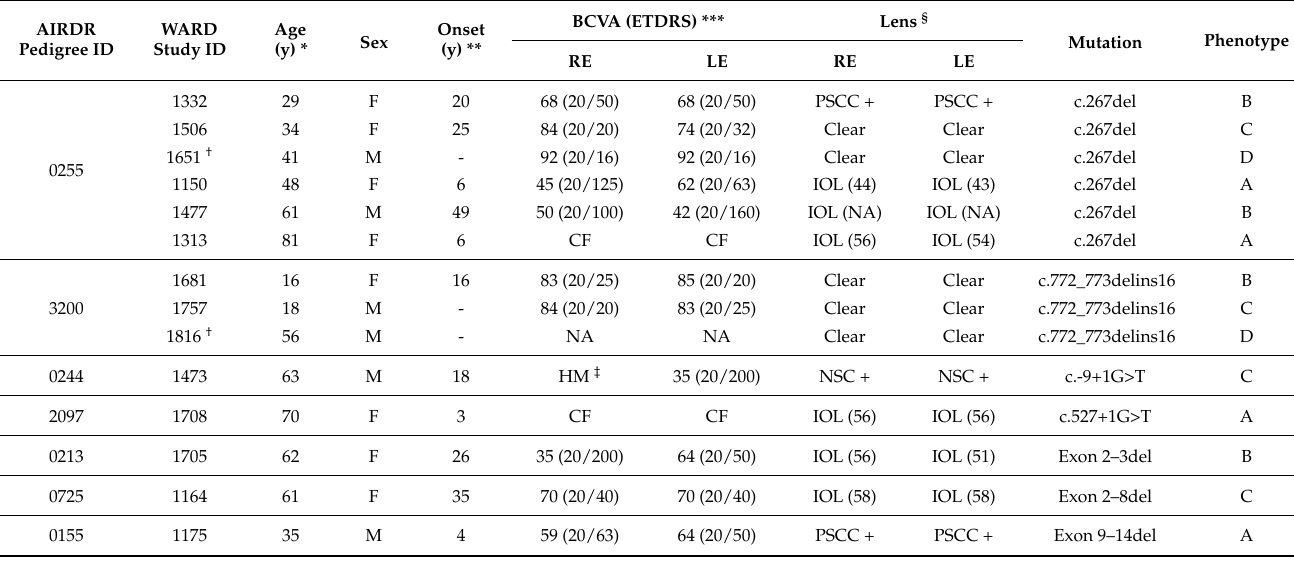
Table 1. Demographics and baseline clinical characteristics of PRPF31 mutation carriers including penetrant ( N = 12) and non-penetrant ( N =